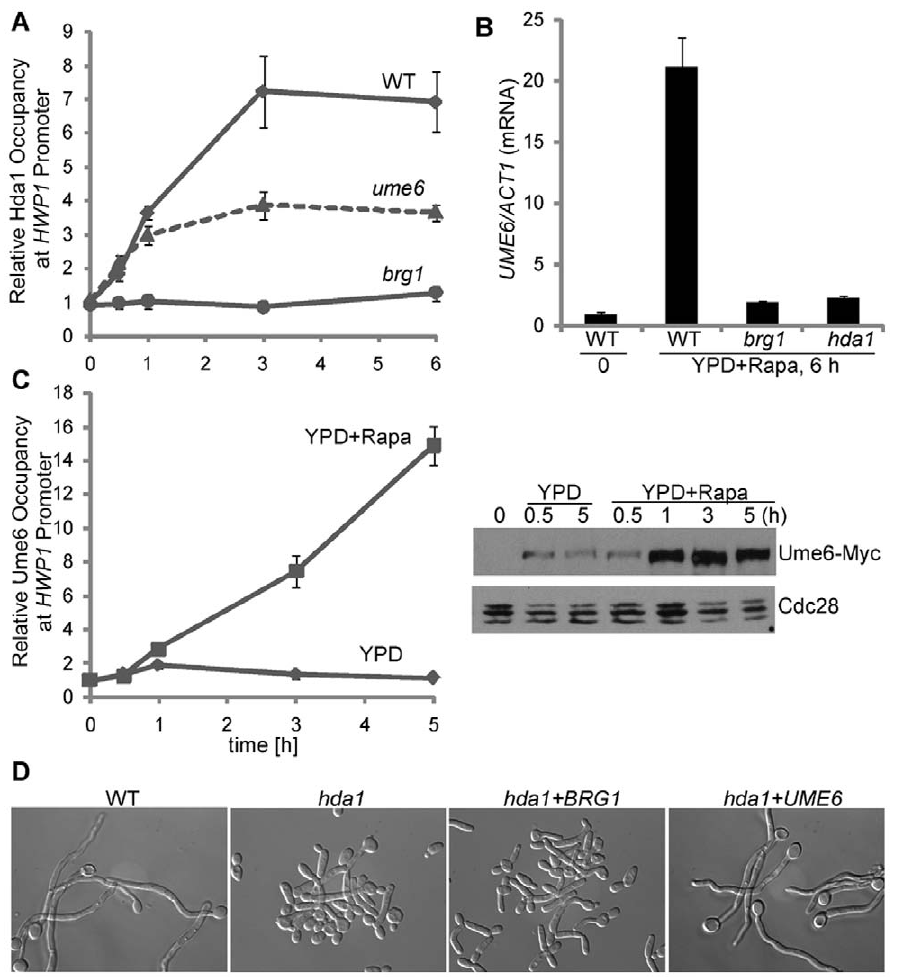
Figure 6. Ume6 functions downstream of Brg1 and Hda1 in hyphal maintenance. (A). Ume6 is not essential for promoter recruitment of Hda1 during hyphal elongation. ChIP of Hda1-Myc in wild type, brg1 , and ume6 mutants in YPD with 10 nM rapamycin at 37 u C. (B). UME6 expression requires Brg1 and Hda1. Expression levels were quantified by qRT-PCR and normalized with ACT1 . All data show the average of three independent qRT-PCR or qPCR experiments with error bars representing the SEM. (C). Ume6 binds to hyphal promoters during hyphal elongation. ChIP and Western analysis of Ume6 in wild type cells (HLY4078) in indicated media. (D). Ectopic expression of UME6 , but not BRG1 , restores filamentous growth in the hda1 mutant. hda1 cells transformed with pBES116 (V), MAL2p-MYC-BRG1 (HLY4077) or MAL2p-UME6-MYC (HLY4076) were grown in YEPMaltose medium with 5 nM rapamycin for cell morphology.